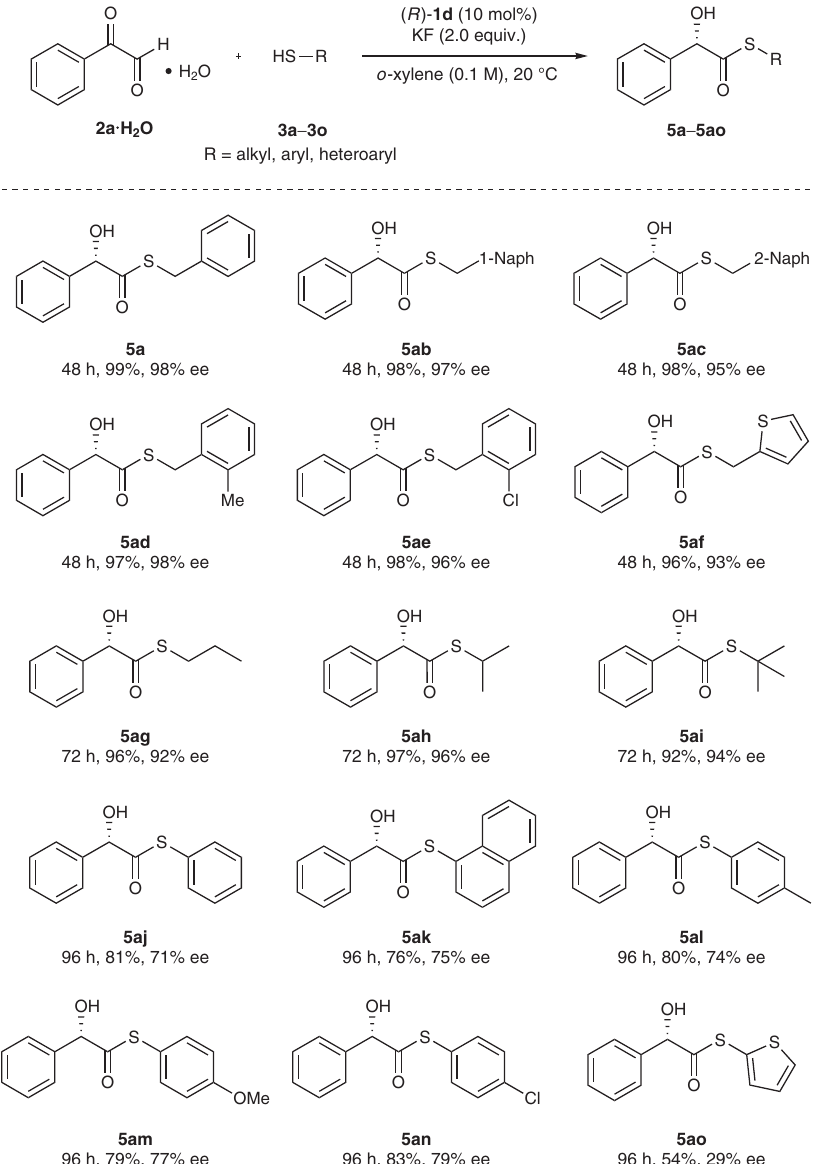
Figure 2 | Thiol screening. The reactions were carried out with 2a (0.1mmol, monohydrate form), 3 (1.0 equiv.), ( R )- 1d (10mol%) and KF (2.0 equiv.) at 20 (cid:2) C. Isolated